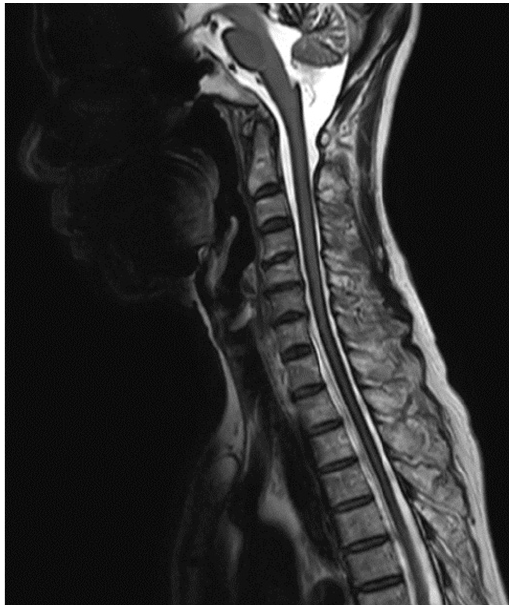
Figure 1. T2-weighted magnetic resonance imaging (MRI) of the cervical to upper thoracic spine reveals hypointensity in the superficial areas of the central nervous system which is characteristic of superficial siderosis. An anterior epidural fluid collection spanning the C7 to T10 levels is also visible. Medicines 2020 , 7 , x FOR PEER REVIEW